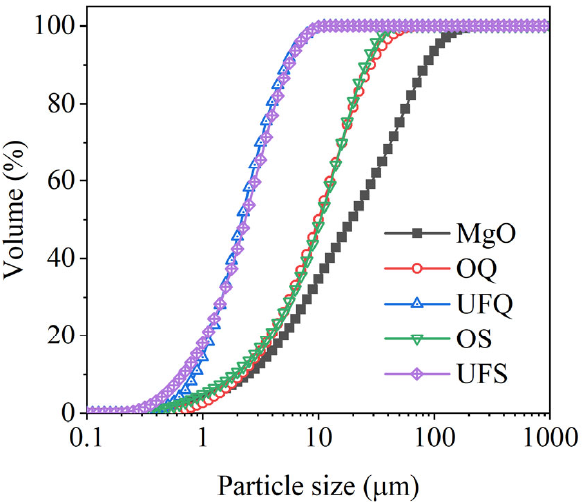
Figure 1. Particle size distributions of raw materials. OQ: ordinary quartz; UFQ: ultrafine quartz; OS: ordinary slag; UFS: ultrafine slag.